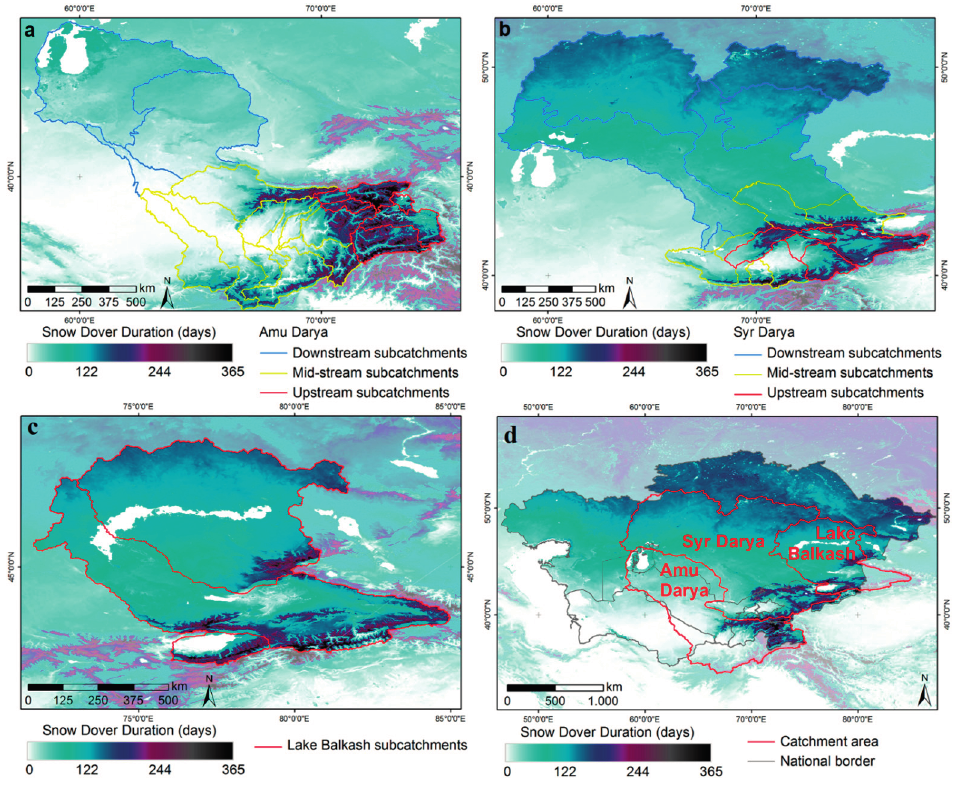
Figure 8. Amu Darya ( a ), Syr Darya ( b ), and Lake Balkhash ( c ) with subcatchments and mean Snow Cover Duration between 2000 and 2013. Overview of whole Central Asia ( d ) with all catchment areas highlighted in